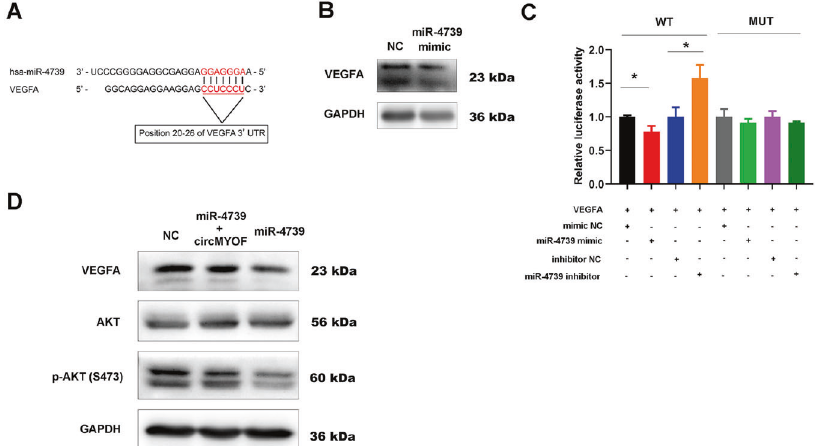
Fig. 8 VEGFA is a direct target of circMYOF/miR-4739. A Schematic image showed that the potential target VEGFA obtained a similar microRNA-response element as the seed sequence of miR-4739. B Western blotting implied that increased expression of miR-4739 repressed VEGFA protein expression. C Luciferase reporter assay demonstrated that the miR-4739 mimic dramatically depressed the reporter activity of VEGFA-WT but not VEGFA-MUT. Augmentation of the reporter activity of VEGFA-WT was observed after adding the miR-4739 inhibitor ( n =